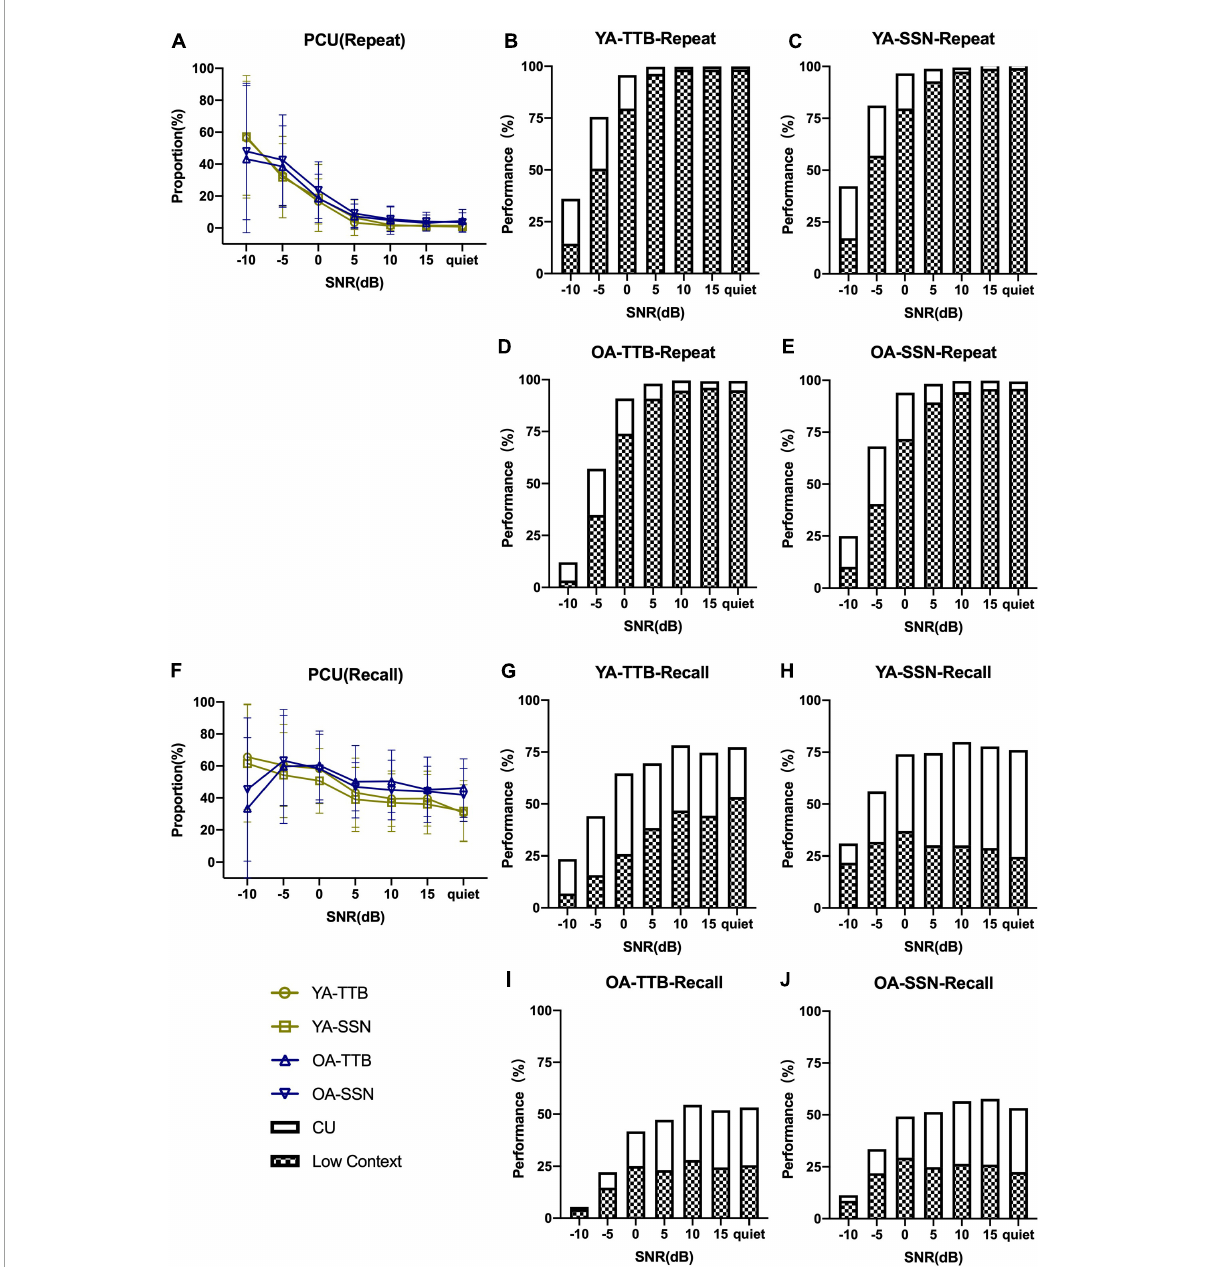
FIGURE3 Proportion of CU in Repeat and Recall of two age groups under two noise conditions and seven SNRs. (A) PCU (Repeat) gradually rose as SNR became even worse. (B–E) PCU (Repeat) in two age groups under two noise types. (F) PCU (Recall) also rose as SNR decrease but in a much smooth trend, and OA failed to rely on context any more in SNR = –10 dB, where acoustic signals were degraded seriously. (G–J) PCU(Recall) in two age groups under two noise types. Hollow bars represented CU and grid represented low-context performance. The combination of the two represented the performance of high-context. Error bars represented one standard